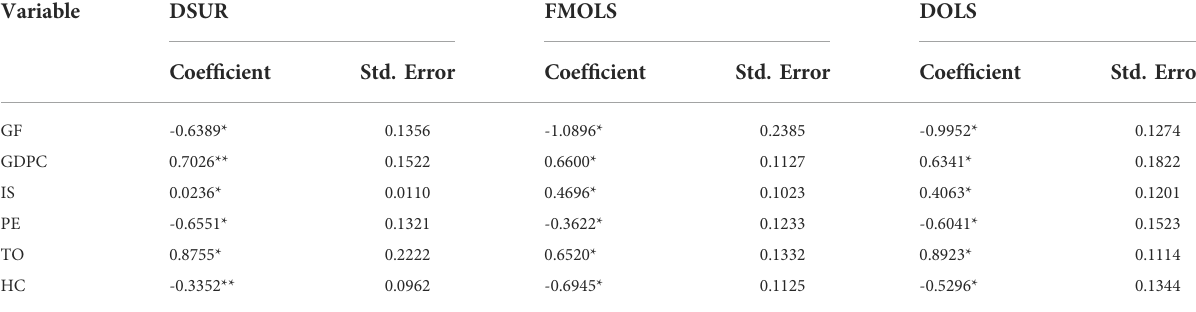
TABLE 6 Outcomes of DSUR, FMOLS and DOLS.